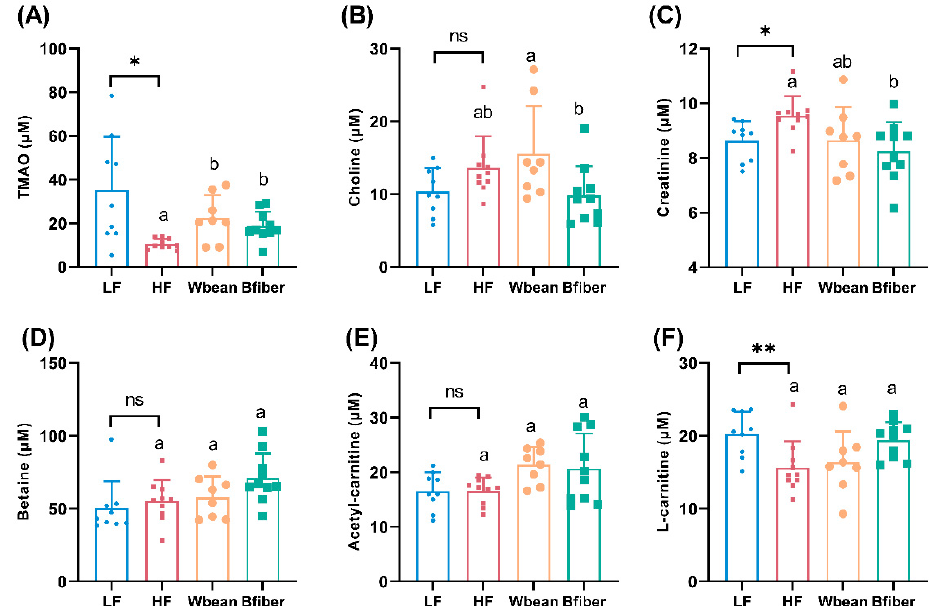
Figure 3. Concentrations ( µ M) of plasma ( A ) trimethylamine N -oxide (TMAO), ( B ) choline, ( C ) creatinine, ( D ) betaine, ( E ) acetyl-carnitine, and ( F ) L-carnitine in Apoe − / − mice fed the low fat (LF), high fat (HF), whole brown bean (Wbean), or bean fiber (Bfiber) diet for 10.5 weeks. Trimethylamine (TMA) concentrations were low (<3 µ M) in all groups and no significant differences were observed. Values in the LF and HF controls were compared using Student’s t -test. Values in the high fat groups, i.e., HF, Wbean, and Bfiber, were compared using one-way ANOVA (Welch’s ANOVA test for data with unequal SDs, or Kruskal–Wallis test for nonparametric data) followed by post hoc tests. Different lowercase letters within panels indicate significant differences ( p < 0.05). ns: not significant. * p < 0.05, ** p < 0.01.